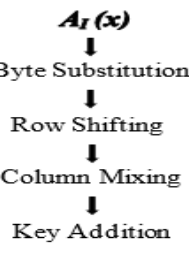
Figure 5 . Round Transformation